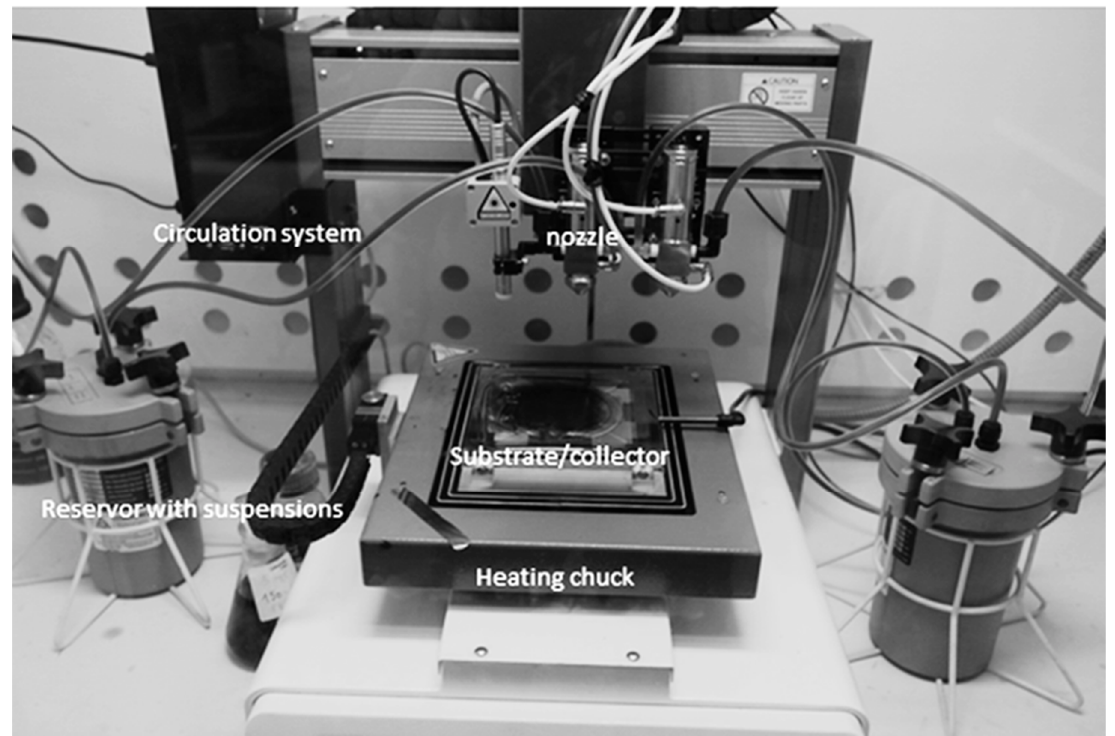
Figure 3. The dynamic spray-gun set-up developed at Thales Research and Technology.